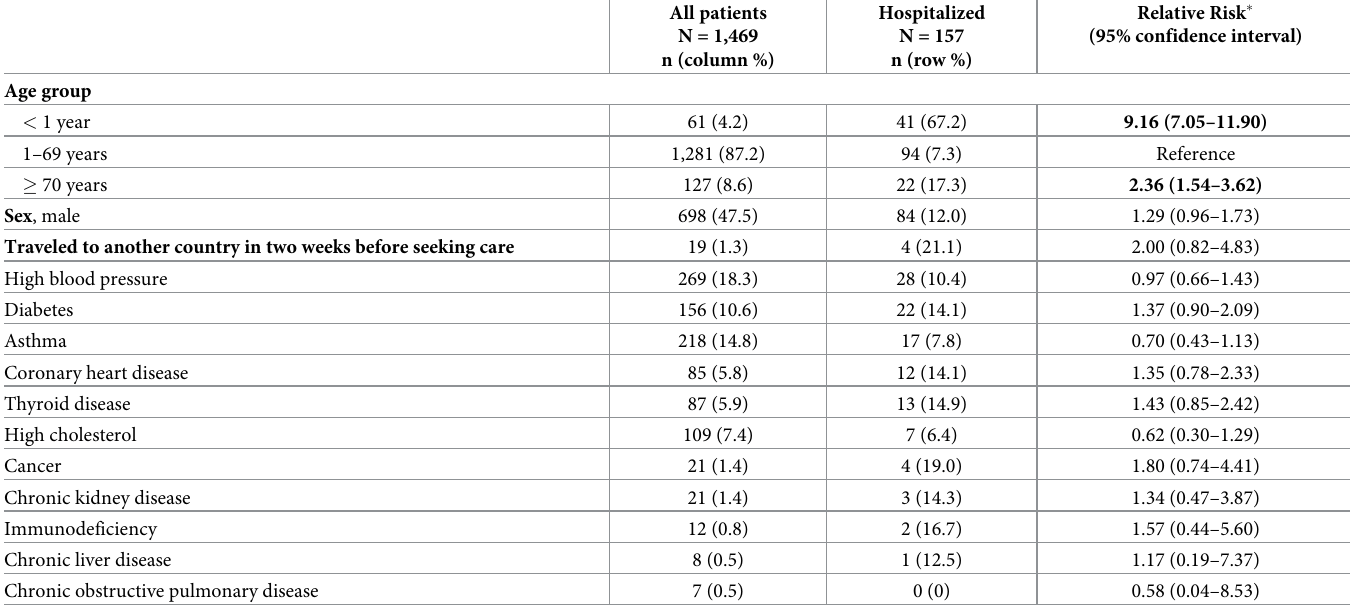
Table 2. Demographic characteristics, travel history, and co-morbidities among hospitalized and non-hospitalized chikungunya virus-infected patients enrolled in the sentinel enhanced dengue surveillance system, May–December, 2014 (N =